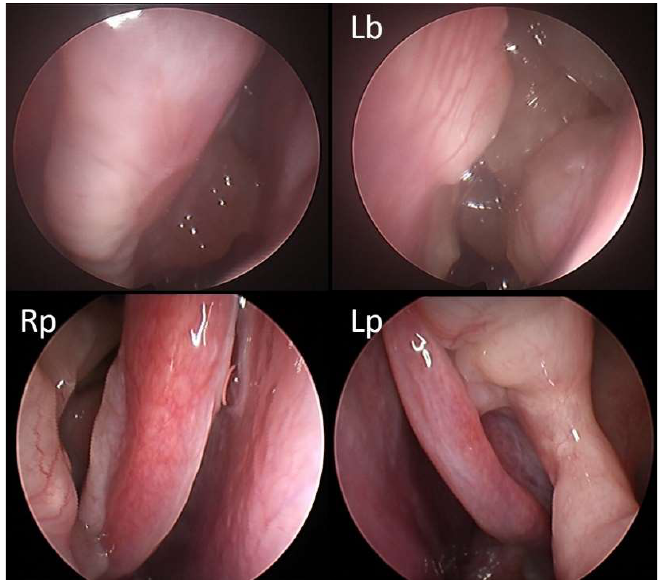
Figure 3. Percentage of response according to EPOS 2020 criteria over the first year of treatment. V0: visit at baseline; V1: 15 days of treatment; V2: 1 months; V3: 3 months; V4: 6 months; V6: 12 months). At 12 months of treatment, according to EUFOREA criteria 2021 [4], 96.5% of patients were eligible to continue dupilumab therapy. Of note, 12/57 patients (21%) already satisfied the criteria at 1 month of therapy and were considered as super early responders (Figures 4–6). In addition, 21/57 patients (37%) satisfied the same criteria within 6 months, and 22/57 patients (38.5%) satisfied the criteria between the 6th and 12th months of treatment.